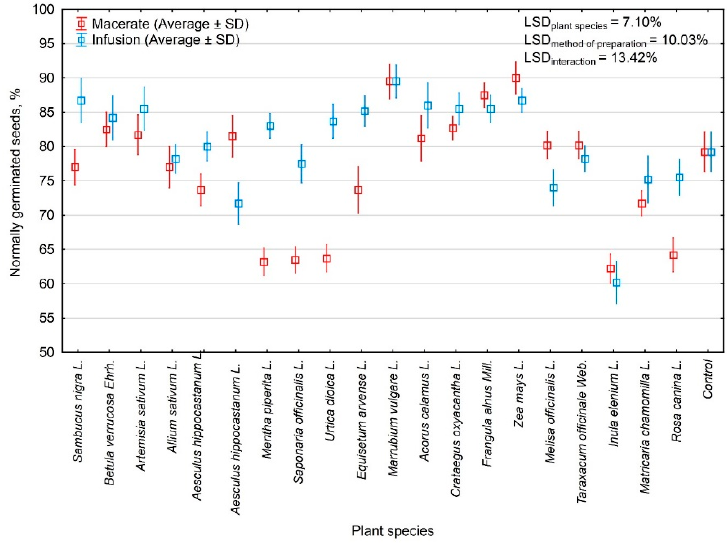
Figure 2. Normally sprouted seeds (%) depending on the species of plant from which the extracts were obtained and the method of extraction. SD: standard deviation, LSD: less significant difference.